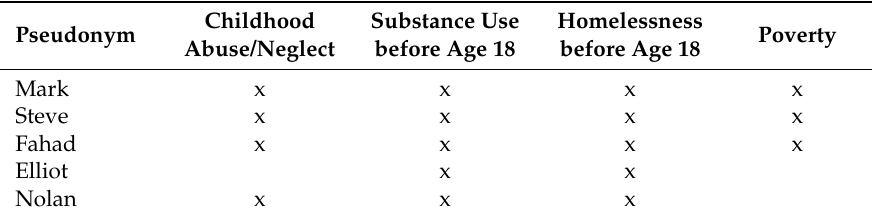
Table 1. Experiences of adversity in youth as reported by case study participants.